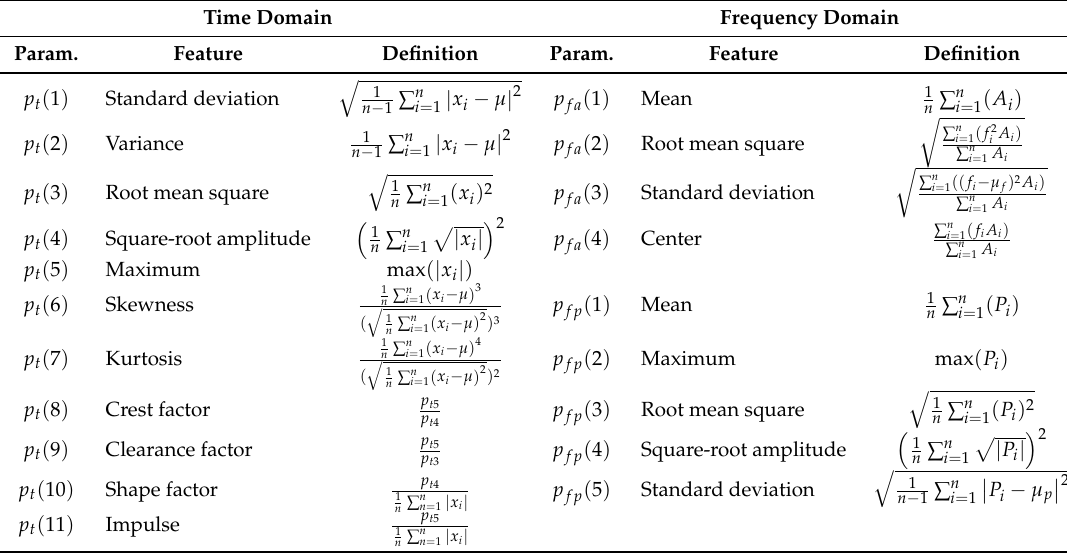
Table 4. Summary of analyzed signal